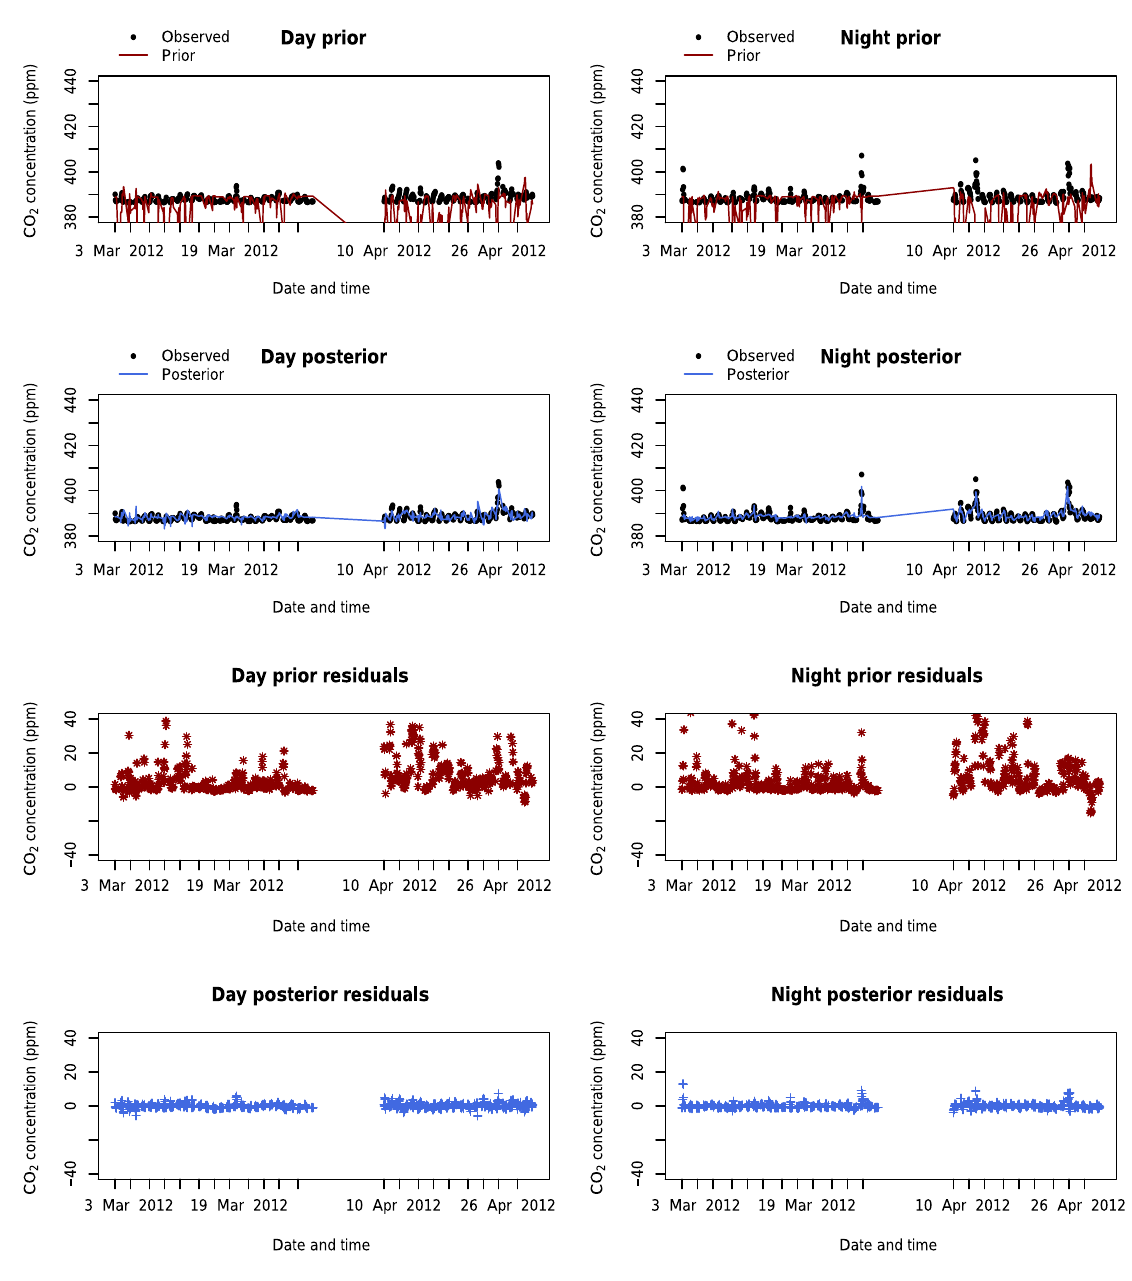
Figure 7. The top four panels provide a time series of the observed, prior and posterior modelled concentrations at the Hangklip site. The time series is separated into day- and night-time periods. The residuals between the observed and prior/posterior modelled concentrations, defined as the difference between the observed and modelled concentrations, are provided in the lower panel four panels. The first 2 months are presented here and remainder of the time series is presented in Sect. 1.4 in the